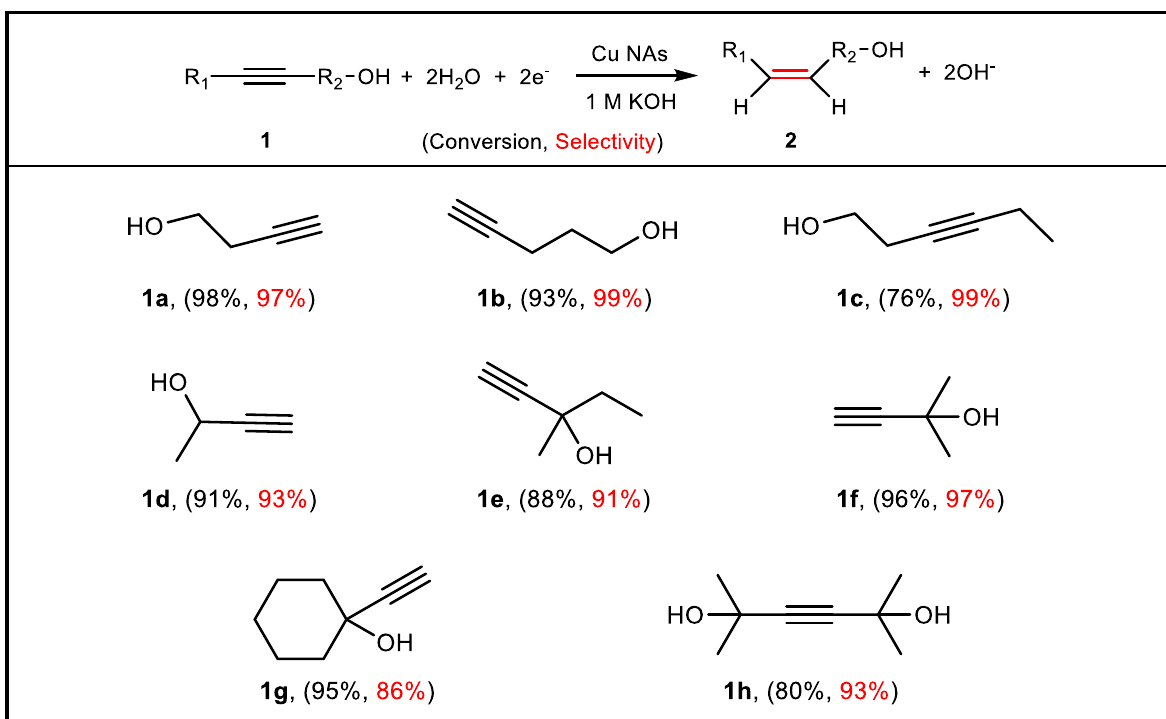
Table 1 | Universality of the electrocatalytic semi-hydrogenation of alkynols on Cu NAs